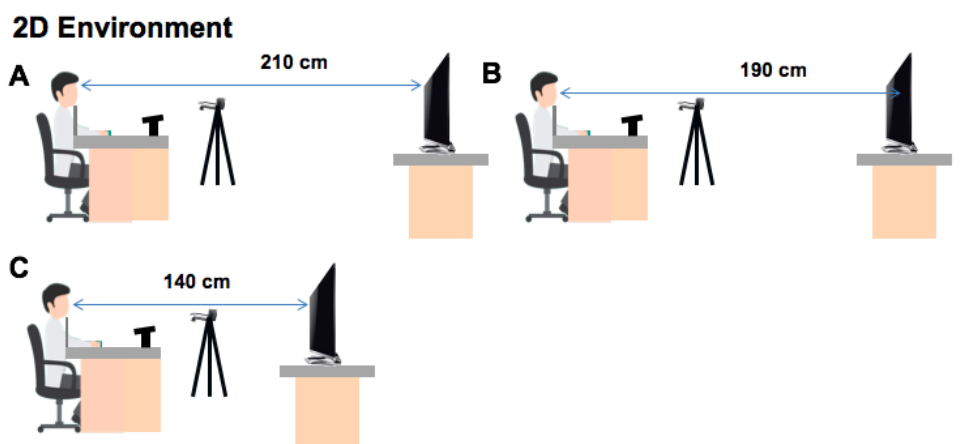
Figure 4. Participant performed the experiment in a 2D environment with distances of ( A ) 210 cm, ( B ) 190 cm, and ( C ) 140 cm. Table 1. ID and task precision level [8].